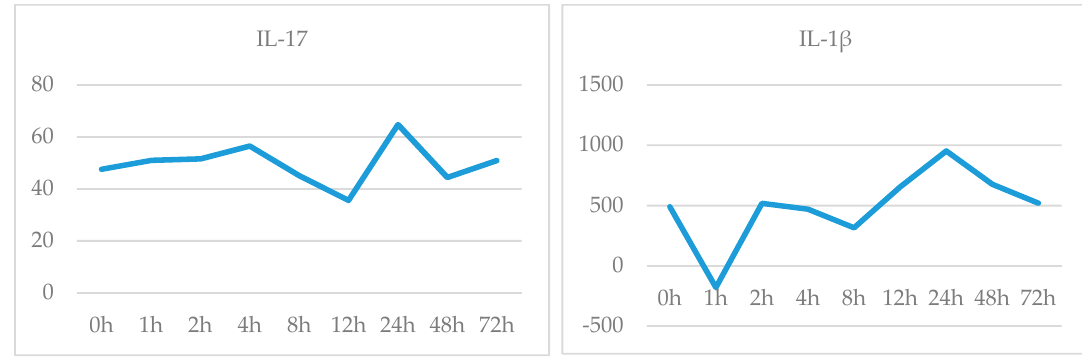
Figure 4. IL-17 (ng/L) and IL-1 β (pg/L) release-time